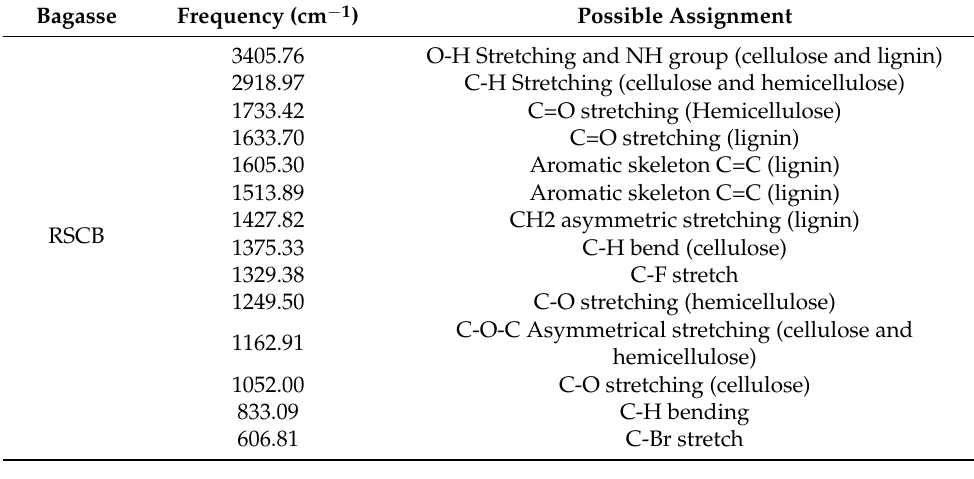
Table 3. FTIR characteristics of RSCB.